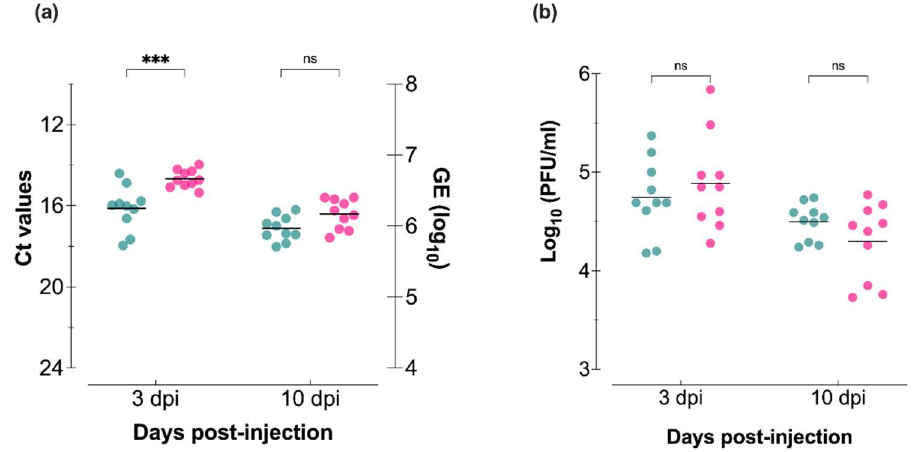
Figure 3. Culicoides midges injected with VSV epidemic lineage 1.1 (NJ0612NME6; teal) and endemic lineage 1.2 (NJ0806VCB; pink) propagated in porcine epithelial cells. ( a ) RT-qPCR cycle threshold (Ct; left Y-axis) and viral genome equivalents (GE; right Y-axis) in individual whole midges. ( b ) Infectious virus of whole-body homogenates as determined by plaque assay on Vero cells. Two-way ANOVA with multiple comparisons used to determine statistical significance as indicated ( n = 10 midges per lineage; p > 0.05, ns, not significant; *** p < 0.001).